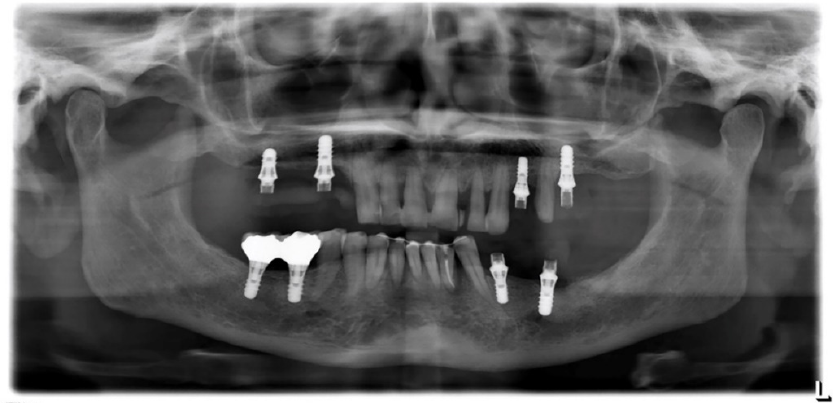
Figure 15. Case 3. Pre-treatment patient characteristics: extra-oral and intra-oral photographic records. ( A ) Extra-oral right profile view; ( B ) extra-oral left profile view; ( C ) intra-oral lateral right view; ( D ) intra-oral frontal view; ( E ) intra-oral lateral left .